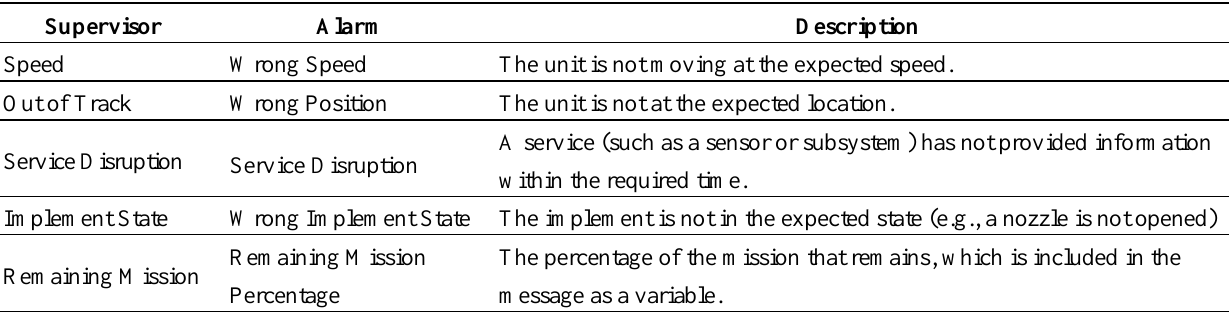
Table 3. Basic-level supervisor